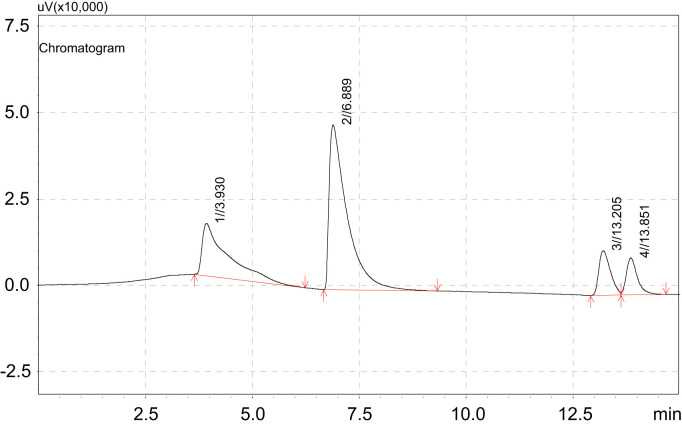
Sample standard.